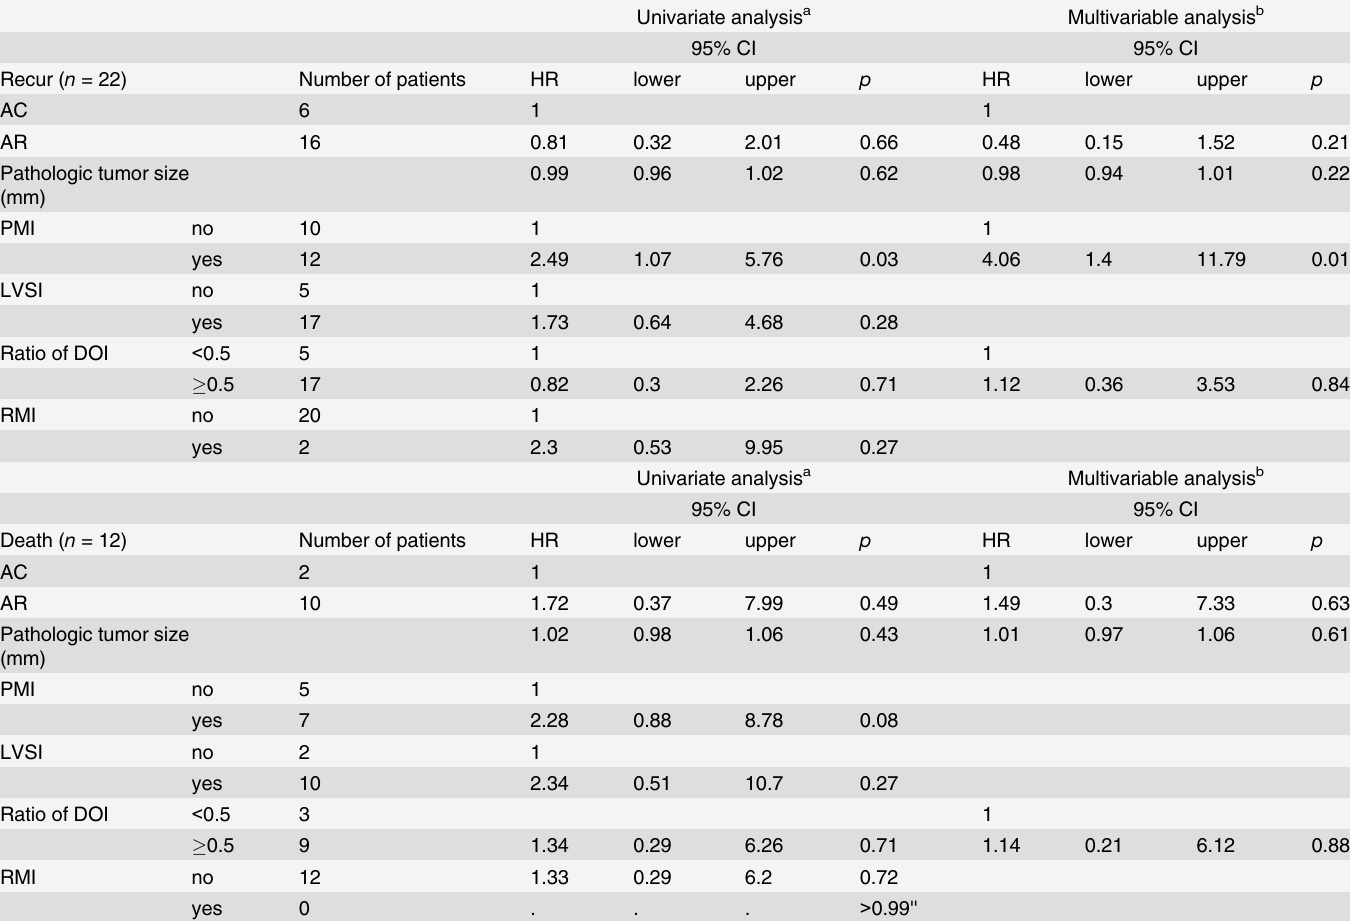
Table 4. Univariate and multivariate analysis of recurrence and death in patients with a nodal